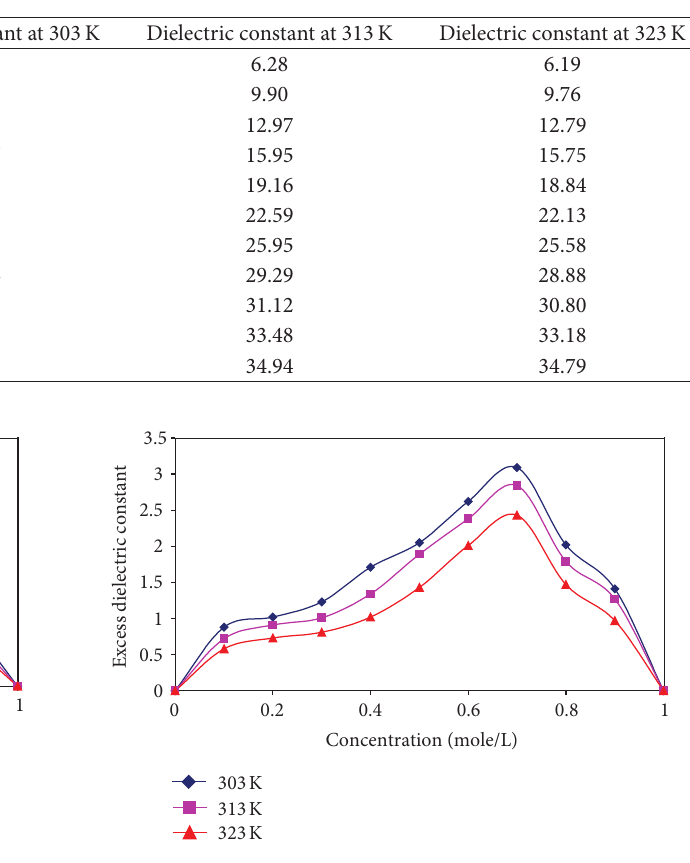
F 1: Excess Dielectric constant for acetonitrile + butyl amine mixture versus concentration at 303, 313, and 323K.